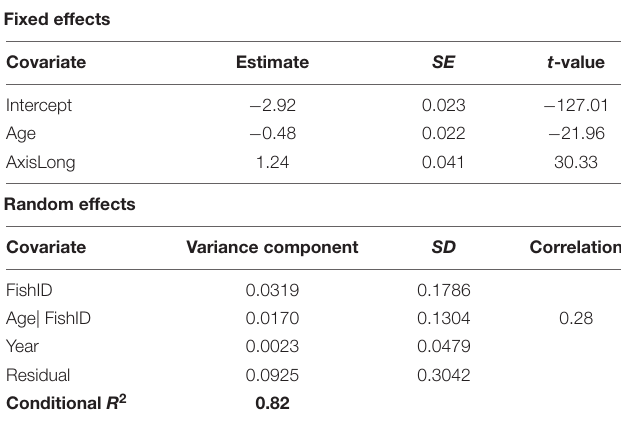
TABLE 3 | Optimal model parameter estimates and test statistics describing Fixed and Random sources of growth variation in Merluccius paradoxus caught along the Namibian coast 1991 to 2013 ( Table 1